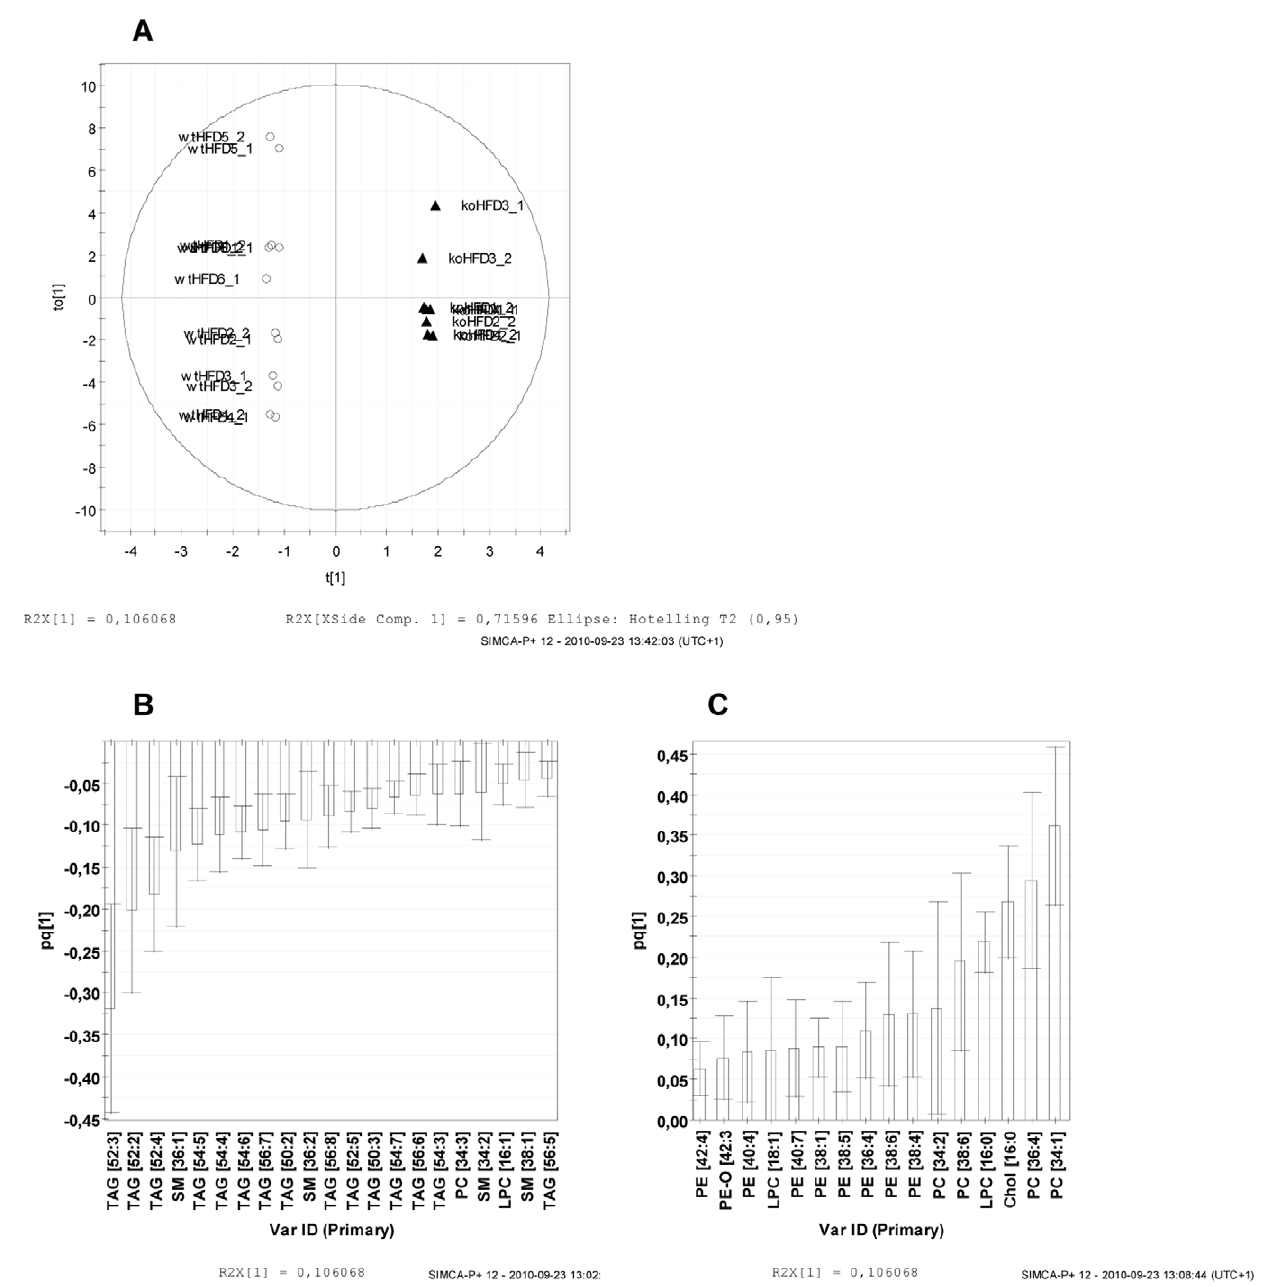
Figure 6. Plasma lipidomics reveals differences between HSL null mice and wildtype mice following a HFD. Orthogonal Partial Least Squares-Discriminant Analysis (OPLS-DA) of plasma lipidomics data was applied to differentiate the HSL null mice on HFD from the control mice with 113 identified lipid species included in the analysis as variables. ( A ) Score plot illustrating clustering of the samples according to the genotype, with each data point on the plot representing the individual plasma lipid profile of an animal. ( B , C ) Loading column plots to visualize the class-separating lipid species with a T-bar corresponding to the 95% confidence interval. Lipid species decreased ( B ) and increased ( C ) in plasma of female HSL null mice on HFD vs. wildtype littermates. doi:10.1371/journal.pone.0021603.g006 16:0 elongation in the liver [25], the increased expression of Elovl1 and 3 seen in the liver of HSL null mice might influence the elongation of 16:0.